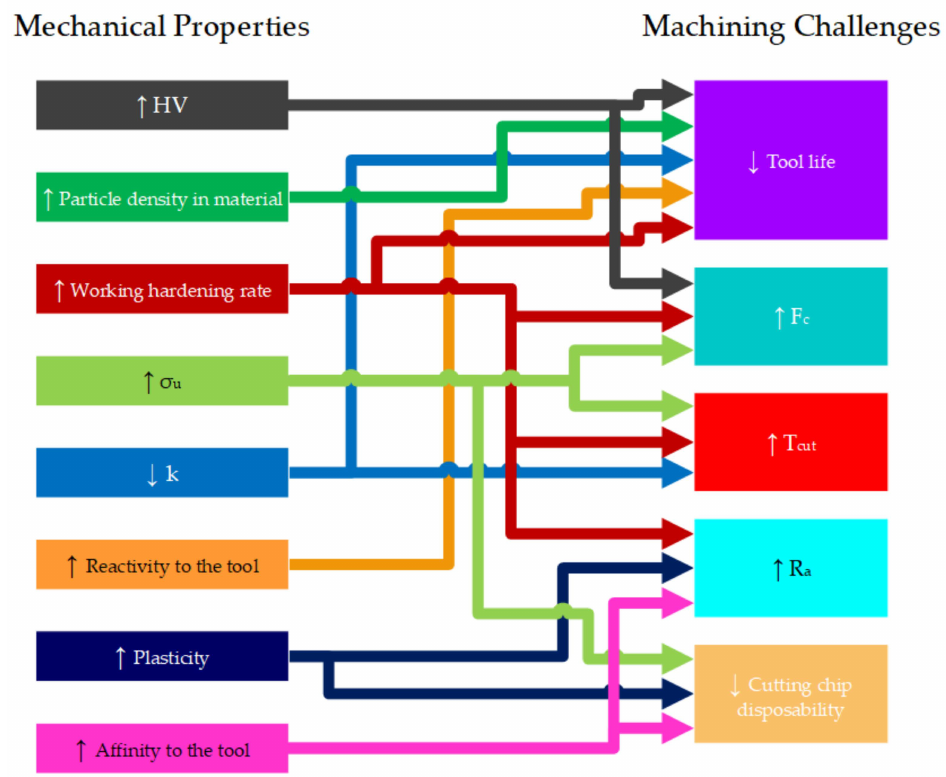
Figure 2. Relationship between mechanical properties and machining challenges with INCONEL ® (adapted from [19]).